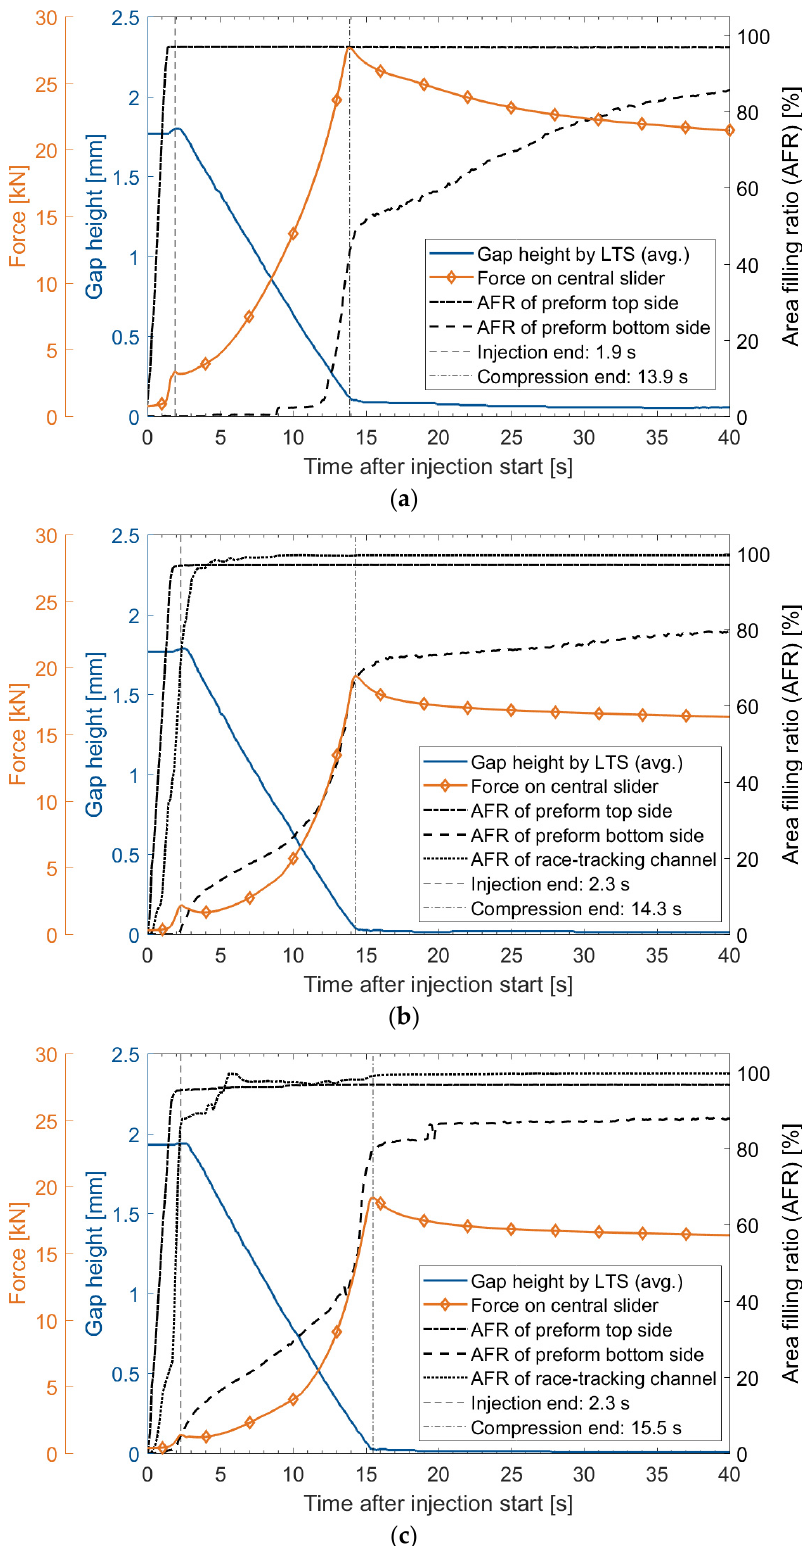
Figure 6. Overview of important process variables during FS-CRTM experiments of the race-tracking study: ( a ) no race-tracking channel—vc-#3; ( b ) medium race-tracking channel width—mrt-#3; ( c ) wide race-tracking channel width—wrt-#1 (LTS = laser triangulation